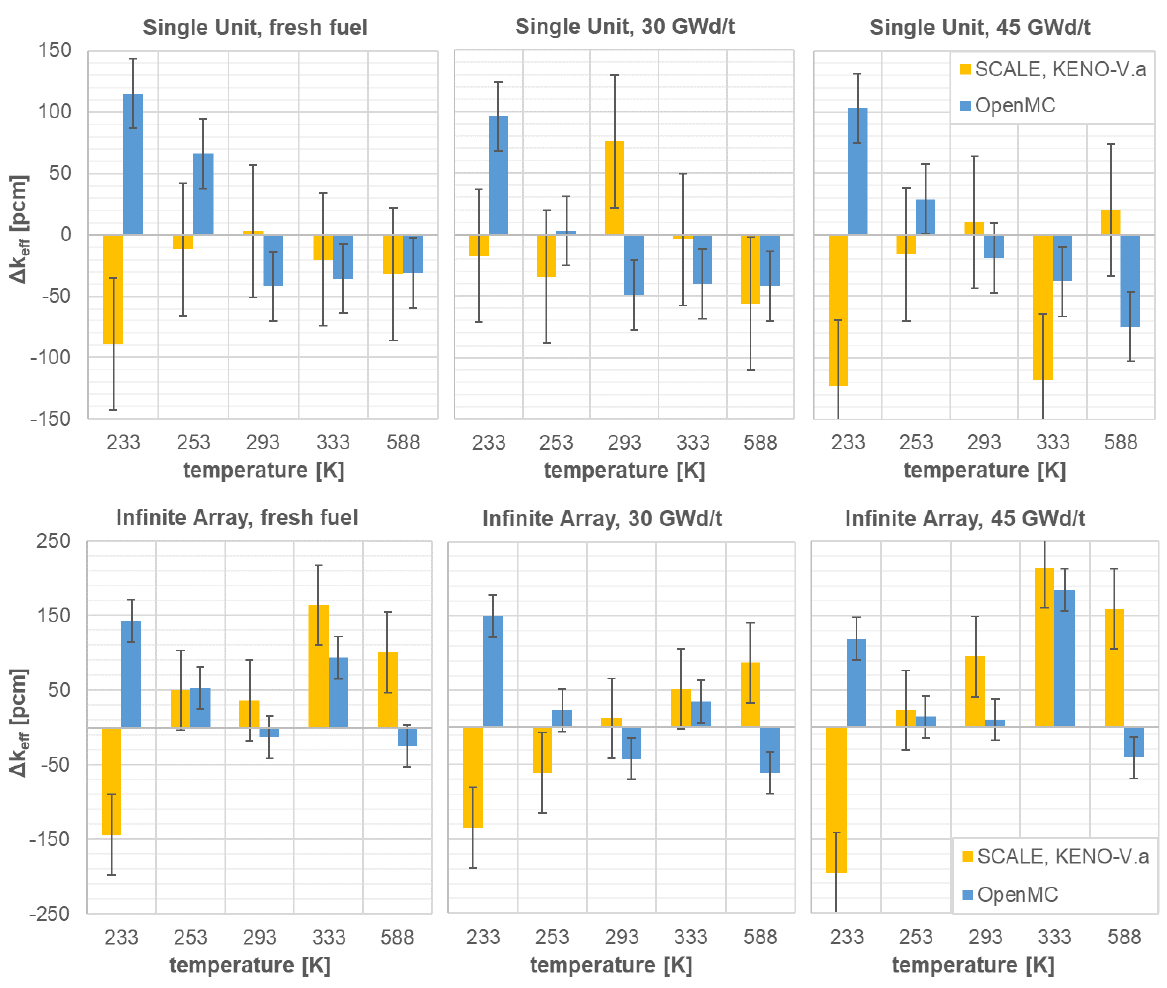
Figure 3. Differences Δk in the neutron multiplication factors between KENO-V.a and MCNP, eff and between OpenMC and MCNP,